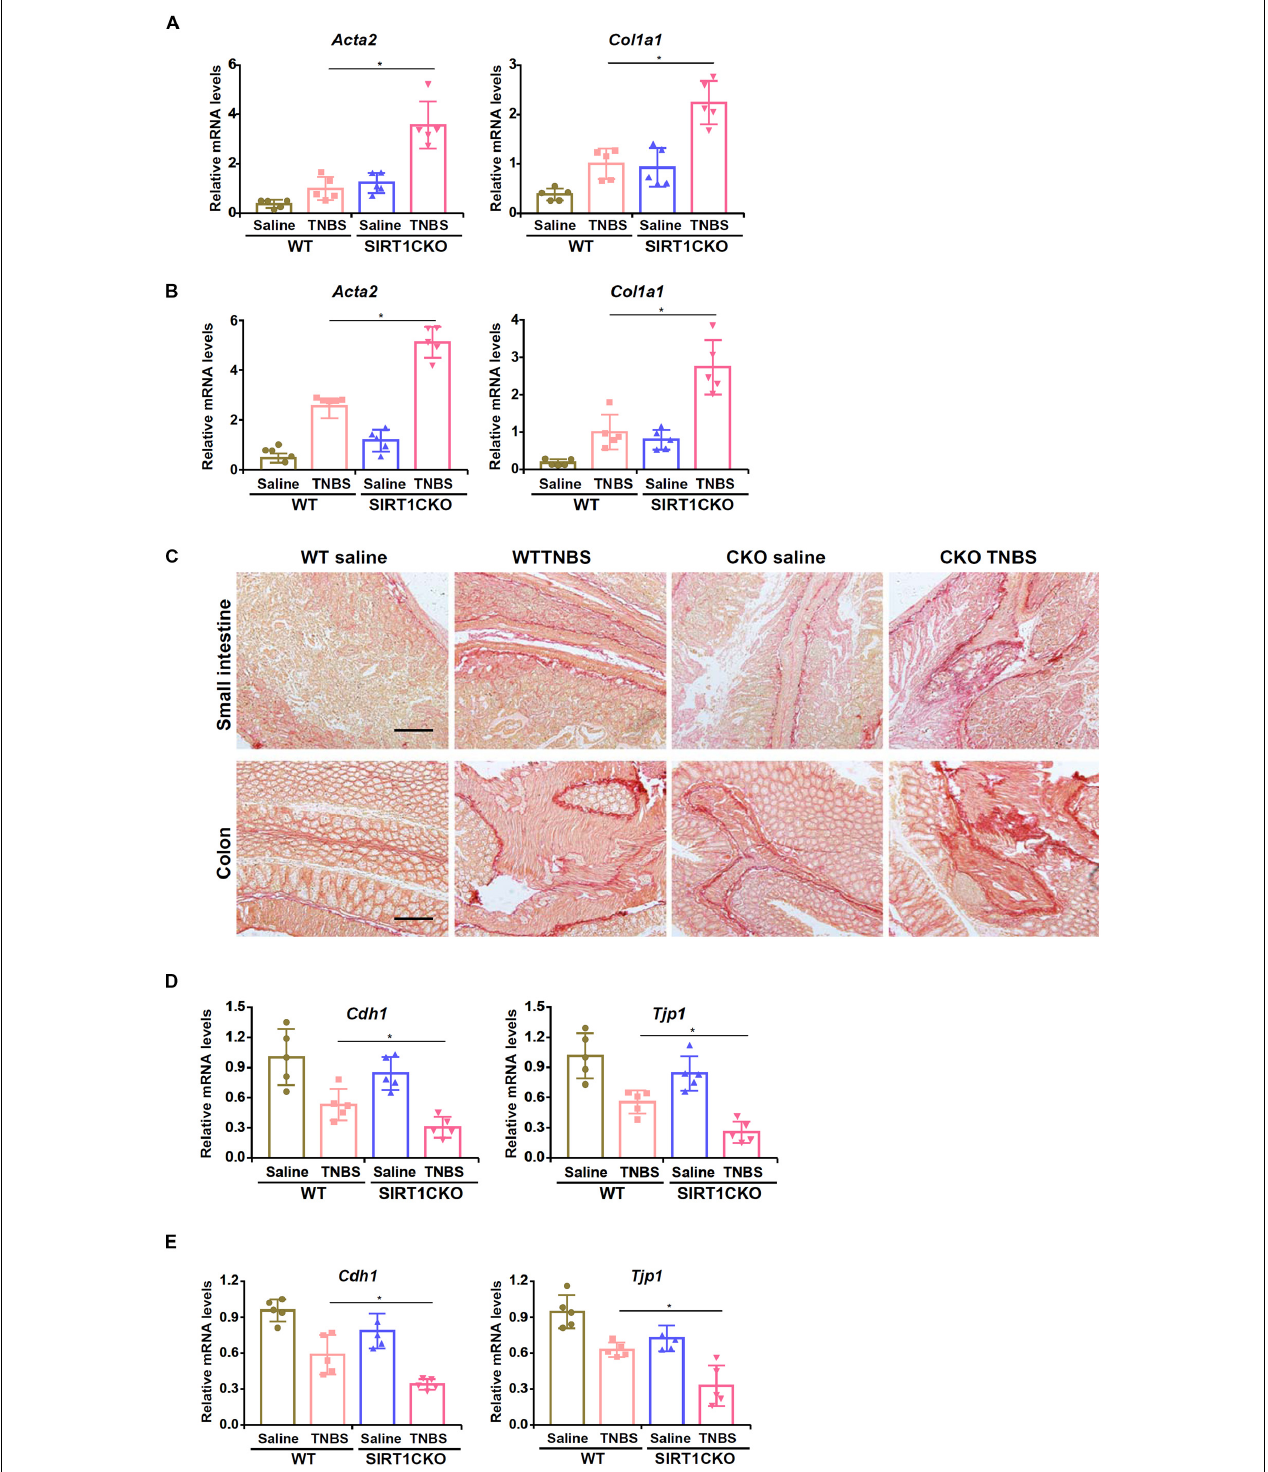
FIGURE 1 | Intestinal epithelial deletion of SIRT1 exacerbates TNBS induced intestinal fibrosis. Intestine-conditional SIRT1 knockout (CKO) mice and wild type littermates were induced to develop colitis and intestinal fibrosis by TNBS injection. (A) Expression levels of pro-fibrogenic molecules in the small intestines were examined by qPCR. (B) Expression levels of pro-fibrogenic molecules in the colons were examined by qPCR. (C) Paraffin sections were stained with picrosirius red. Scale bar, 100 mm. (D) Expression levels of epithelial marker genes in the small intestines were examined by qPCR. (E) Expression levels of epithelial marker genes in the colons were examined by qPCR. N = 5 mice for each